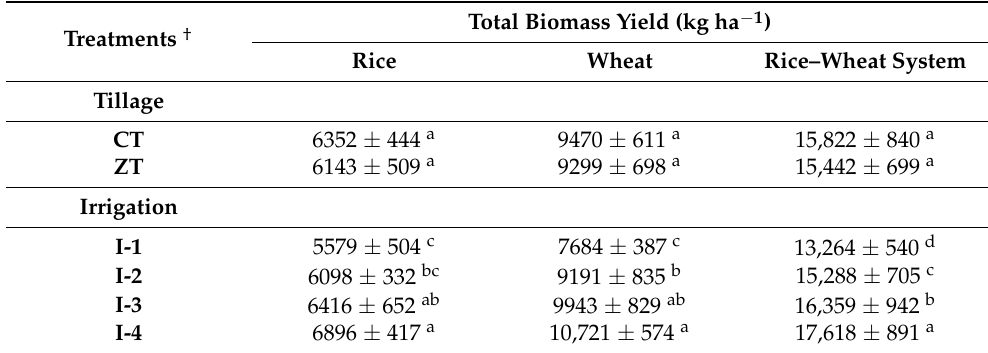
Table 5. Biomass yield of rice and wheat as influenced by different management